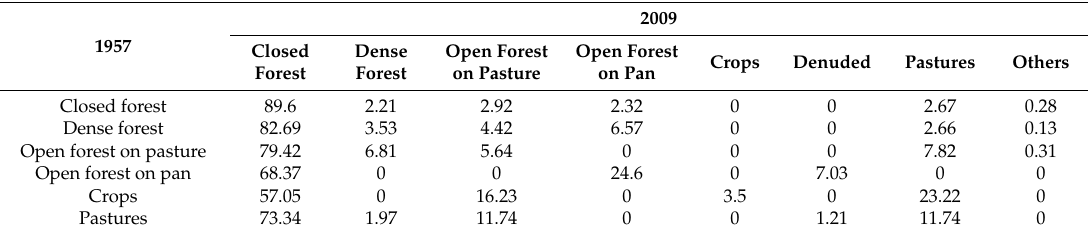
Table 5. Transition matrix of land uses and cover classes (%) between 1957 and 2009.